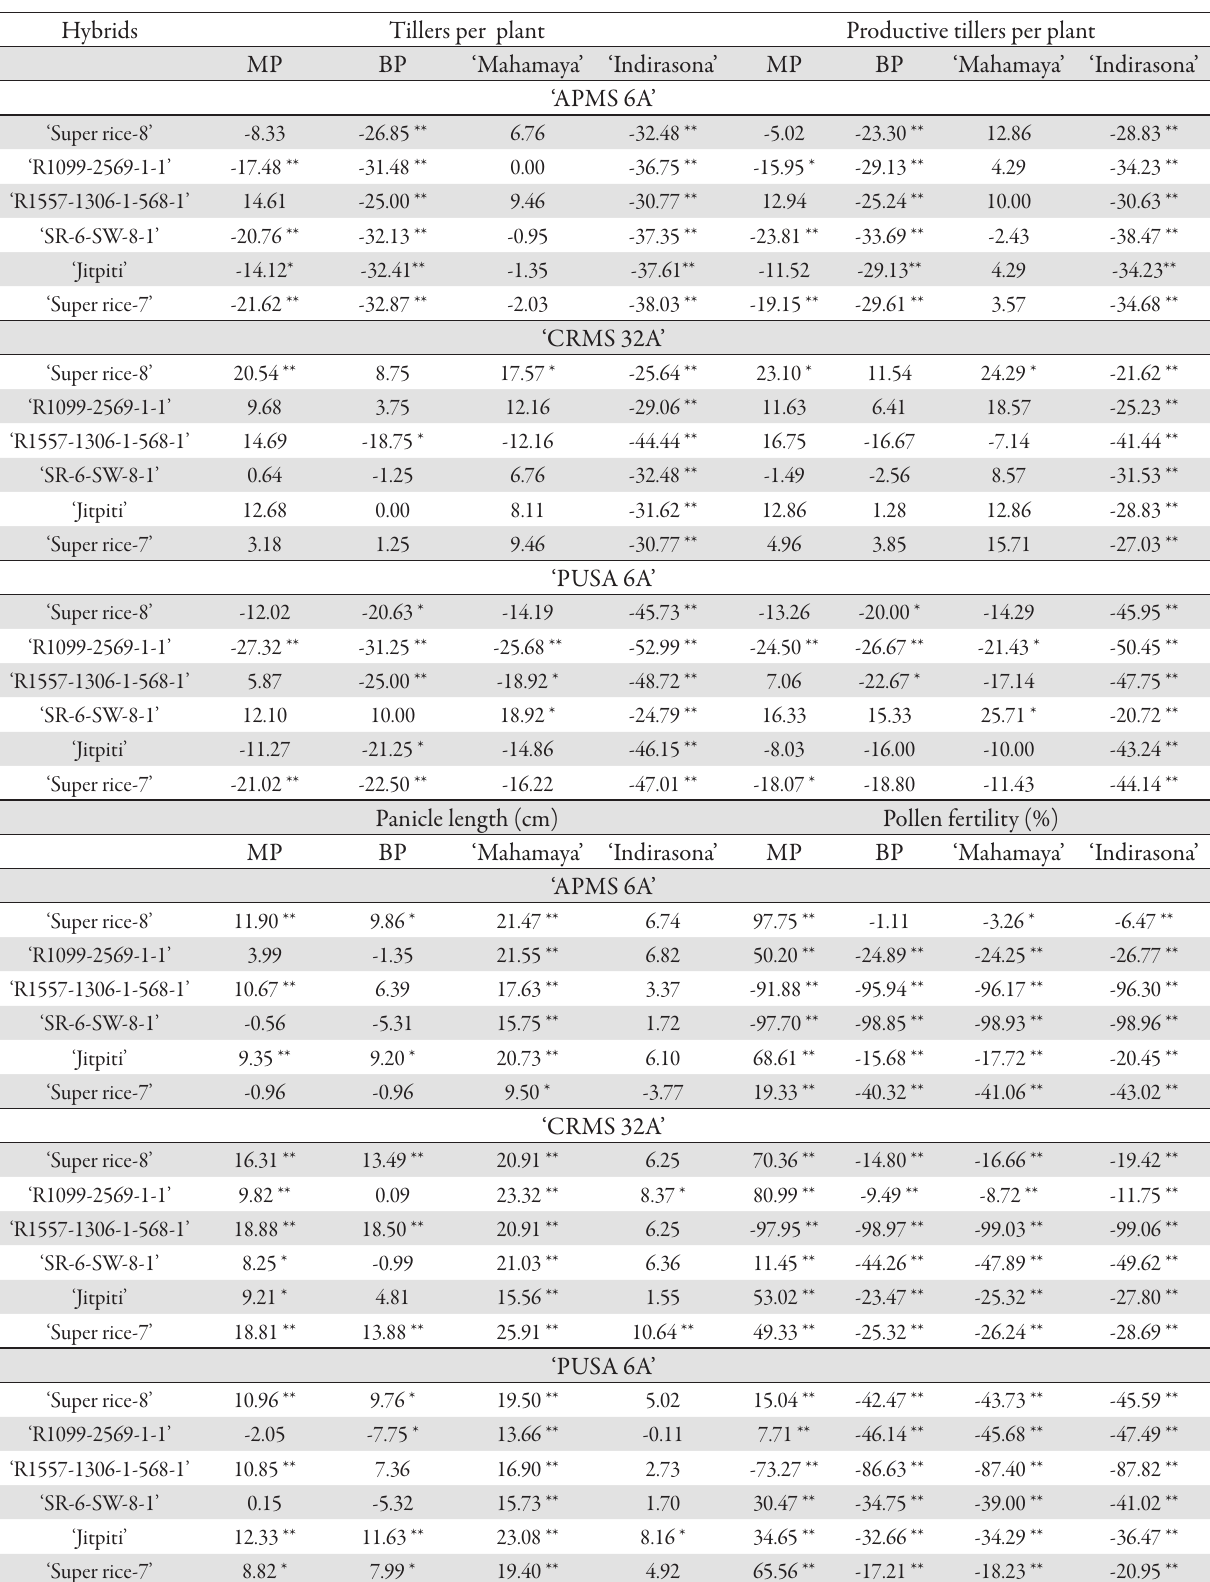
Tab. 3. Percent relative heterosis, heterobeltiosis and standard heterosis for different characters in rice (Continuous)